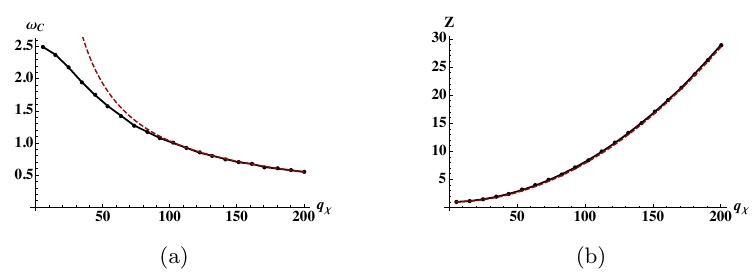
Figure 3 . q (cid:31) dependence of ! C (peak frequency) and Z (height of the peak). Dotted lines are ! C = a q (cid:0) 1 (a) and Z = b q 2 + 1 (b). (cid:31) (cid:31)